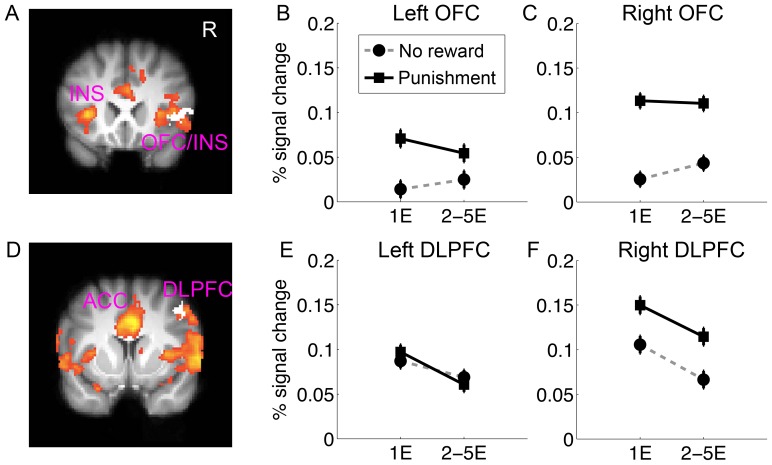
Neural response to punishment compared to no reward.Significant activation for in the lateral OFC and insula (A), the DLPFC (D), as well as in ACC and bilateral insula, are overlaid on coronal slices of the group mean structural image. All activations were thresholded by using cluster detection statistics, with a height threshold of z>2.3 and a cluster probability of P<0.05, corrected for whole-brain multiple comparisons. The right OFC and right DLPFC ROIs showing common reversal effect for reward and punishment are shown in white color, on panel A and D respectively. Their left homologues were defined by a left-right flipping. Percentage signal change in the left (B) and right (C) OFC, the left (E) and right (F) DLPFC, is plotted as a function of learning stage (1E vs. 2–5E), feedback type (no reward vs. punishment). Error bars indicated with-subject standard error. 1E: first error; 2–5E: error trials during repetitions 2 to 5.